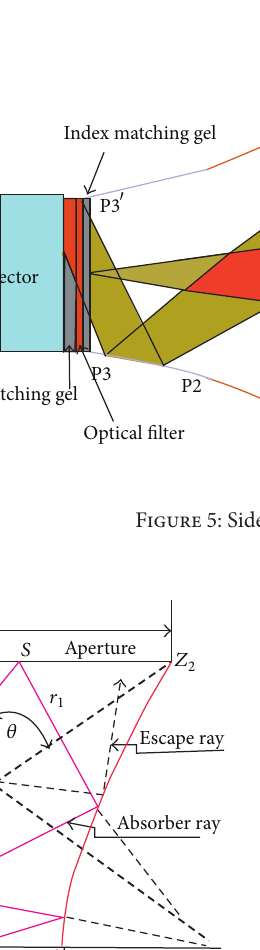
Figure 7: 3-D elliptical hyperboloid